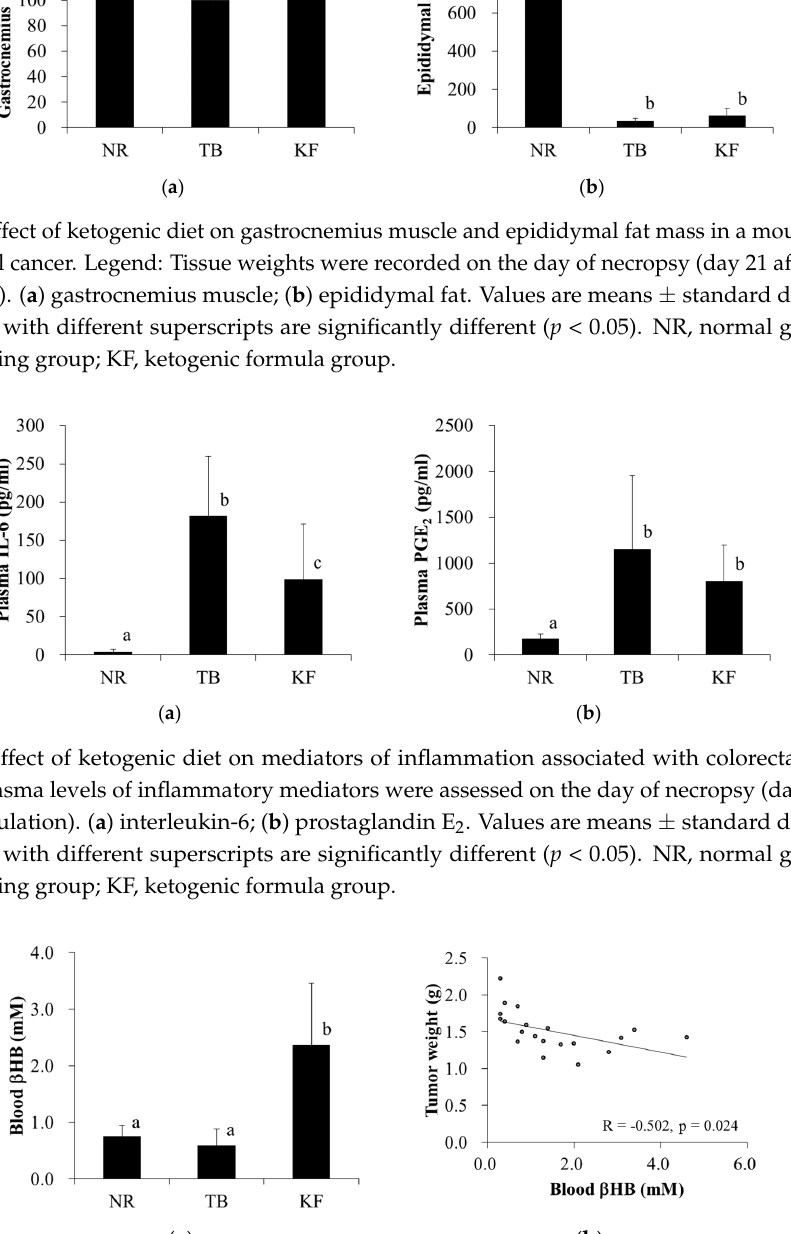
Figure 5. Effect of ketogenic diet on β -hydroxybutyrate ( β HB) levels in a mouse model of colorectal cancer. Legend: ( a ) blood β HB levels were assessed on the day of necropsy (day 21 after tumor inoculation); ( b ) correlations between blood β HB levels and tumor weights were determined. Values are means ± standard deviations, and values with different superscripts are significantly different ( p < 0.05).